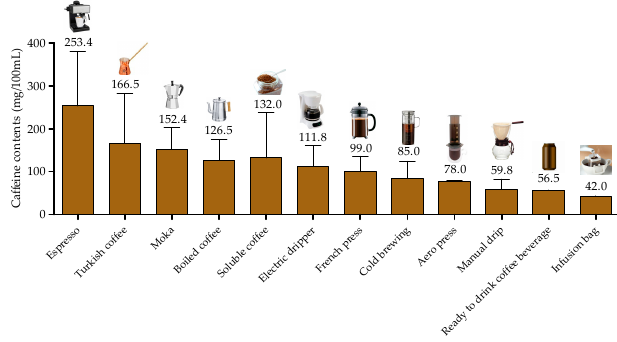
Figure 2. Mean reported ca ff eine contents (mg / 100 mL) in co ff ee brews obtained from a variety of blends, and by di ff erent preparation methods (values extracted from Table